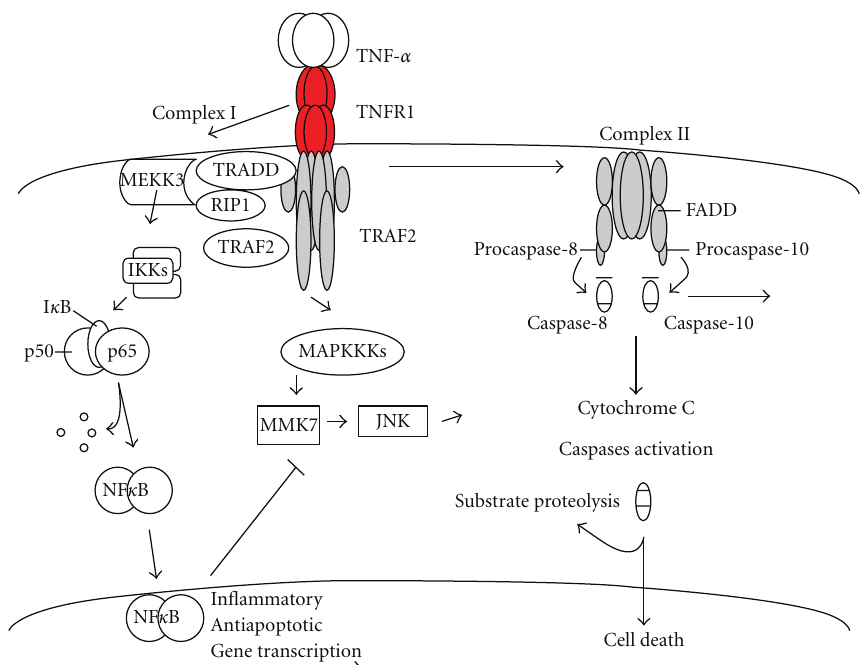
Figure 2: Formation of the NF κ B-stimulating TNFR1 signaling complex. The classical NF κ B pathway is activated by a broad range of stimuli, including TNF- α . Binding of TNF- α to TNFR1 triggers recruitment of the death domain-containing proteins RIP1 and TRADD. Next, complex TRAF2-cIAP1/2 is recruited to TNFR1-bound TRADD. Recruitment of IKK2 subunit to TRADD-bound TRAF2 stimulates kinase activity of the IKK complex, following by proteolytic degradation of I κ B proteins. p65/p50 complex (NF κ B) is translocated to the nucleus to activate transcription of target genes. Alternative NF κ B pathway (not shown) is activated by a limited subgroup of TNF ligands and involves activation of NIK-mediated stimulation of IKK1 and conversion of p100-containing NF κ B complexes into p52-containing NF κ B complexes by proteolytic processing of p100 to p52. In addition, in TNF-mediated apoptosis, receptor aggregation results in recruitment of the adaptor protein Fas-associated death domain (FADD/MORT1) and caspase-8. Caspase-8 becomes activated and initiates apoptosis by direct cleavage of downstream e ff ector caspases. The mitochondrial pathway is initiated by the release of apoptogenic factors such as cytochrome c , or Smac from mitochondria into the cytosol, which trigger caspase-3 activation through the formation of the cytochrome c /Apaf-1/caspase-9-containing apoptosome